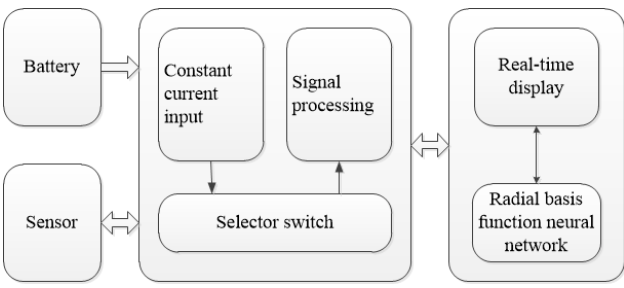
Figure 16. Structure diagram of the signal processing system.